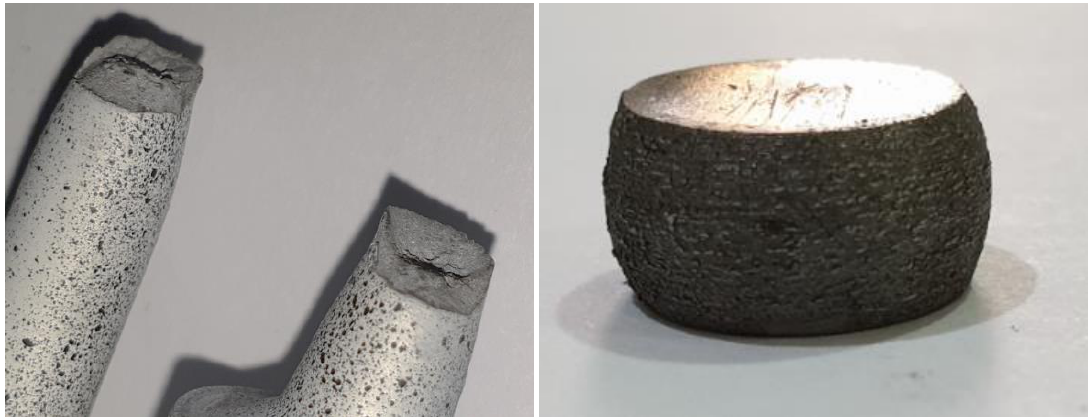
Figure 7. A flat fracture mode surface for “D2” tool steel under tension ( left ) and flattened shape of the cylindrical specimen ( right ) under compression.